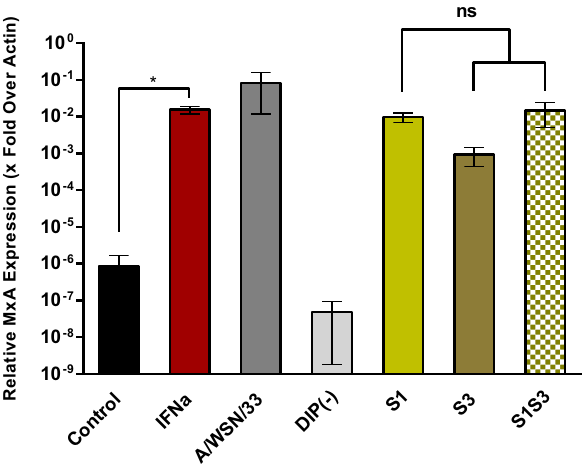
Figure 4. The presence of two DI RNAs does not increase MxA induction. Calu-3 cells were either treated with interferon α or inoculated with IAV (A/WSN/33) or DIPs at an MOI of 0.1. Cell lysates were harvested 24 h after treatment or infection, RNA was isolated and MxA expression was analyzed by quantitative real time PCR. MxA transcript levels were normalized against transcript levels of β-actin. The average of three independent experiments is shown as x-fold over actin. Error bars indicate SEM. Two tailed paired student t-test was used to assess statistical significance. p < 0.5 = *, ns: not